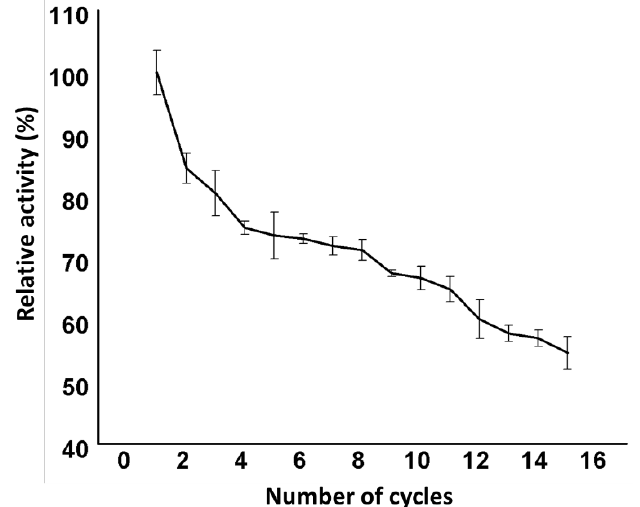
Figure 8. Reusability of the immobilized Man/Cel5B.